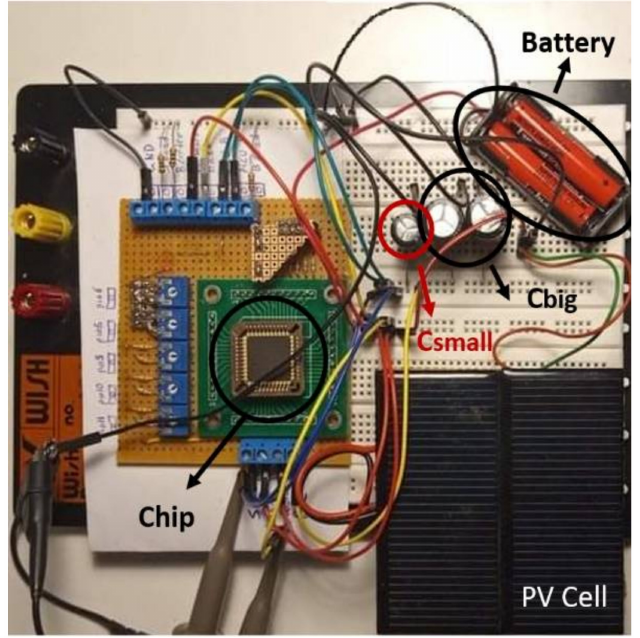
Figure 12. Experimental setup for testing the storage unit in indoor light energy harvesting condi- tions.